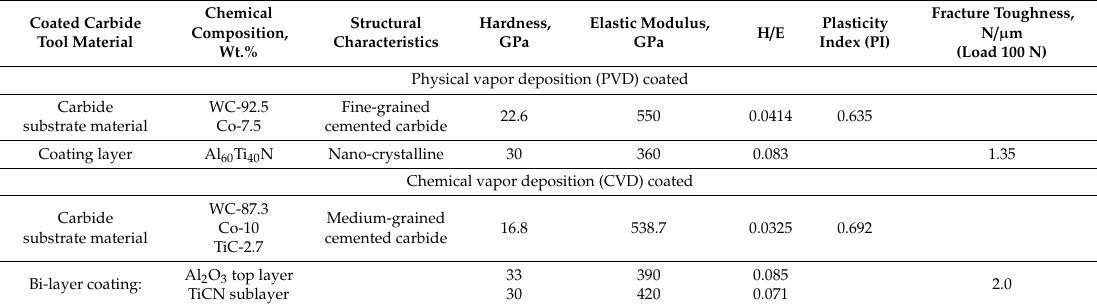
Table 1. Composition, structural characteristics and micro-mechanical characteristics for the coatings/carbide substrates [9]. (Reproduced from [9], with permission from publisher Elsevier, 2019.).